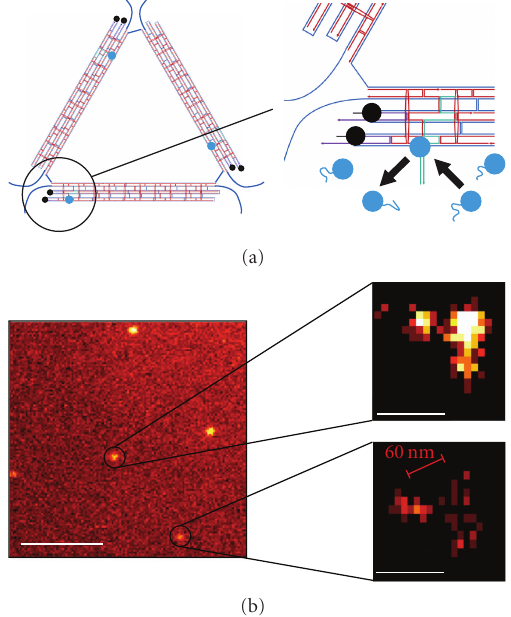
Figure 4: DNA PAINT measurements on the triangular base of the tetrahedron. (a) Design schematic of the base showing docking sites for complimentary biotin- and ATTO655-conjugated oligonucleotides. The sca ff old path is shown in blue, and staples lacking extended docking sequences are in red. Only basal struts 1, 2, and 3 are shown in the full schematic (left), and local detail at docking sites on strut 1 is given (right). The six extended staples containing docking sites for complimentary biotin-nucleotides are shown in purple, with biotin and the a ffi xed nucleotide strand in black. Likewise, the three docking staples for ATTO655 dye are shown in green, while the ATTO655 dye and attached 8-base nucleotide which transiently hybridize to the structures are in light blue. (b) Resolution of triangular structure via DNA PAINT. (Left) Sample frame and (right) superresolution 2D reconstruction of local binding events. In the color scheme on the reconstructions, lighter colors correspond to a higher number of binding events, showing the underlying triangular form matching the schematic arrangement of dyes. For a comparison, the approximate expected distance between docking sites of 60 nm is indicated in the image. Scale bars: 4 μ m (left) and 100 nm